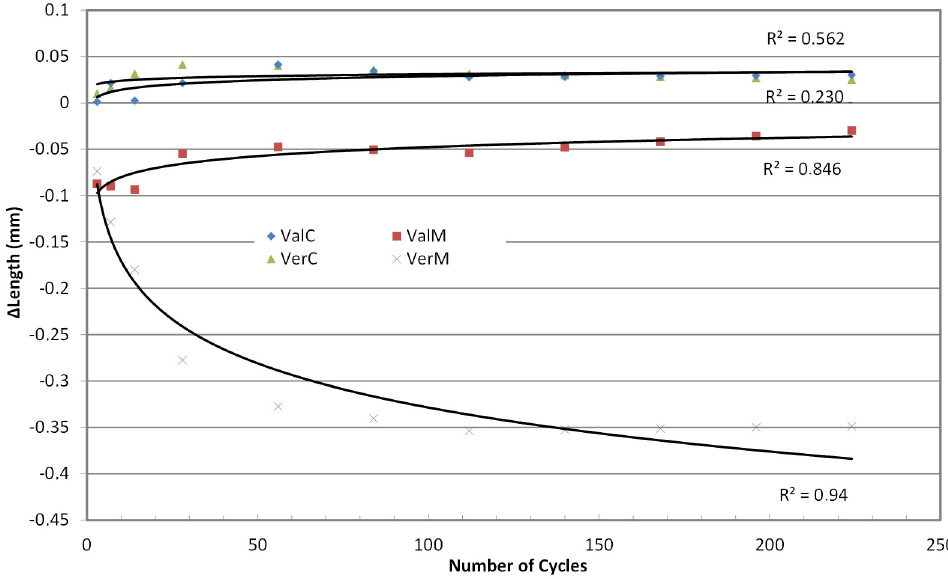
material in the control group was found at around 497.46 nm, while that in the microwave group was found at around 953.89 nm. Ra values for PMMA were at 47.9 nm and 79.83 nm respectively. The above indicates a two times higher value for microwaved materials and ten times higher for the